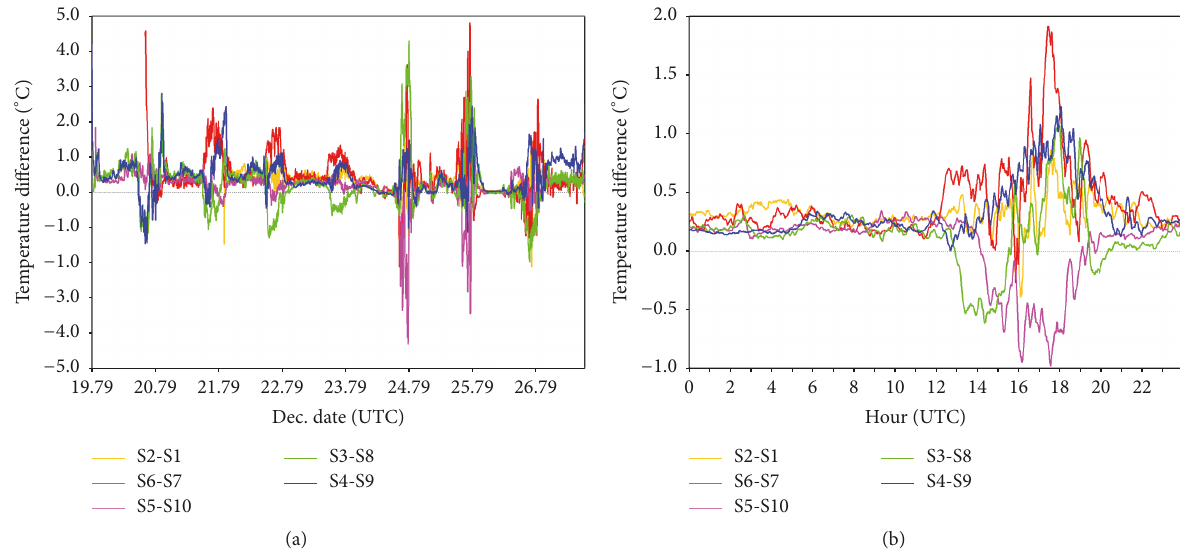
Figure 5: (a) Temperature differences between 2 m and 1m above the glacier surface (19–26 March 2015), as recorded by the Tinytags at the five glacier stations (Figure 1); and (b) mean daily profiles (22–26 March 2015) of the data shown in Figure 5(a).